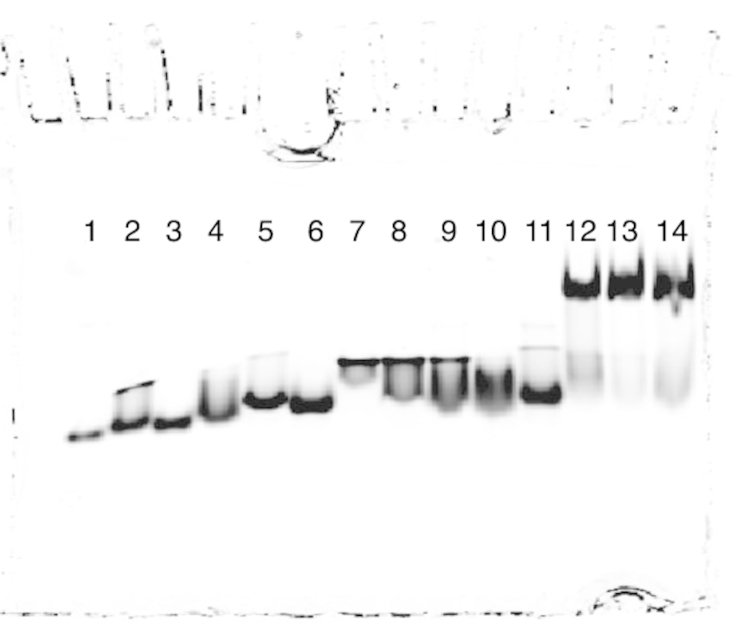
Comparison of multi-DNAs vs. J1, 4WJ:PNA3 and b4WJ:PNA3.